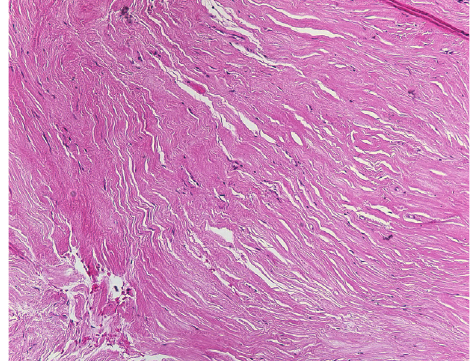
Figure 2: Fat-saturated T1 post-Gadolinium images show mixed intermediate signal in the lesion with moderate heterogeneous generalized enhancement. There is no adjacent edema or reaction in the bone or soft tissues. Small areas of low signal (arrows) are present.